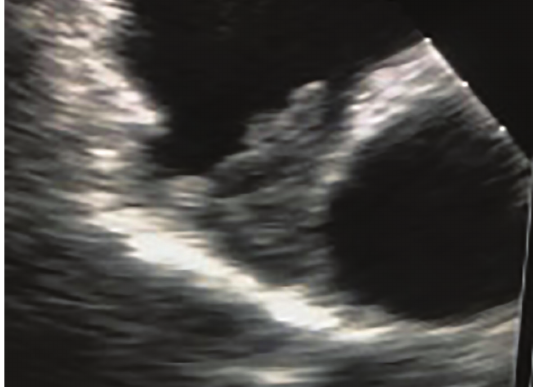
Figure 2C - LAA thrombus confirmed by TEE in the same patient